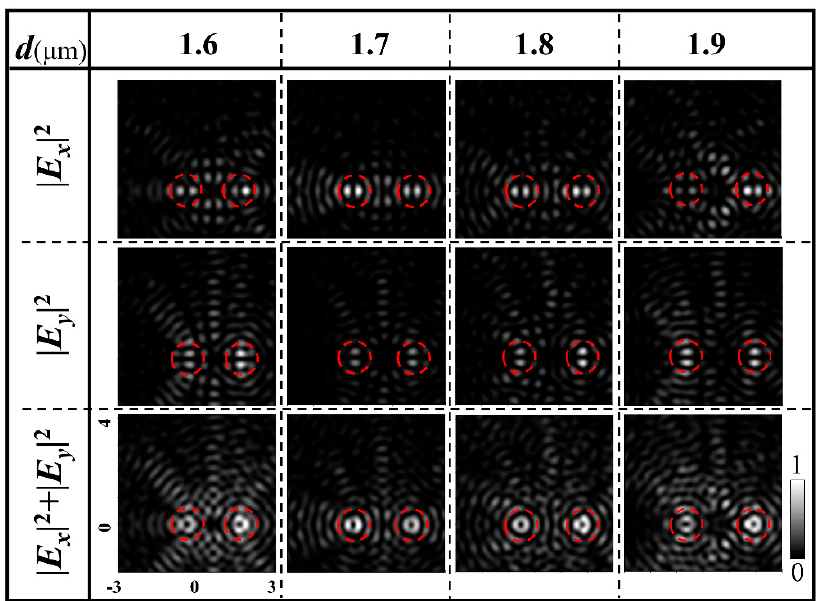
Figure 6. The evolution of intensity patterns of the two radially polarized dual VBs with the increase in distance d between the two beams.